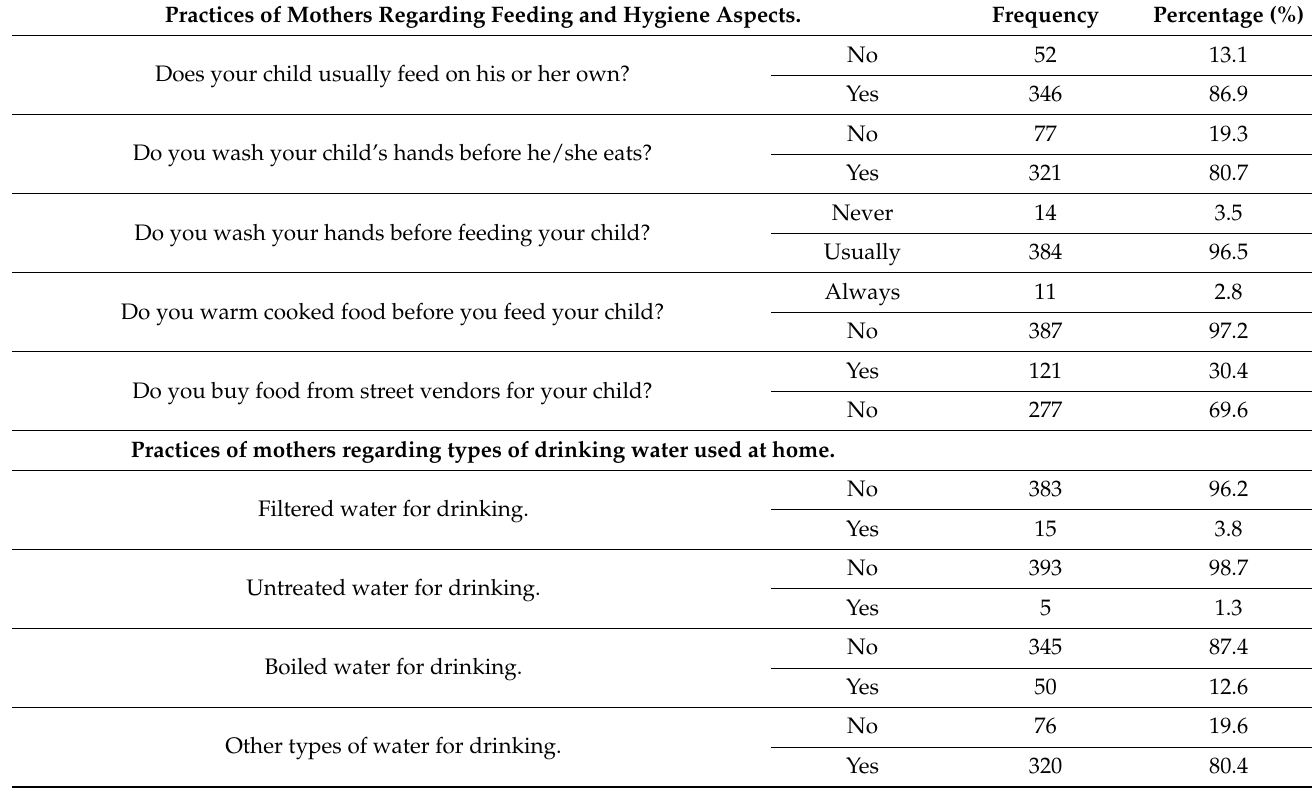
Table 3. Maternal practices for food and water safety in the prevention of diarrhea for children < 5 years. Practices of Mothers Regarding Feeding and Hygiene Aspects.